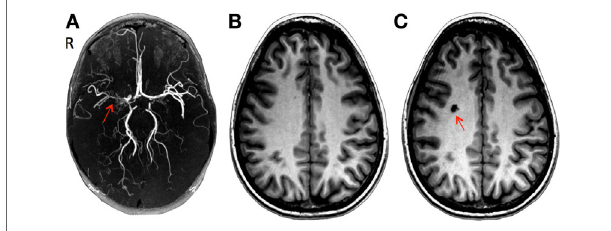
FIguRe 1 | (a) Three-dimensional time-of-flight magnetic resonance angiography (MRA): severe stenosis in the right middle cerebral artery (red arrow). (B) Brain T1-weighted 3D spoiled gradient echo sequence MRI in June 2007 after initial presentation and (C) after the development of a lacunar infarct in the right centrum semiovale (red arrow) during a follow-up in September 2007.